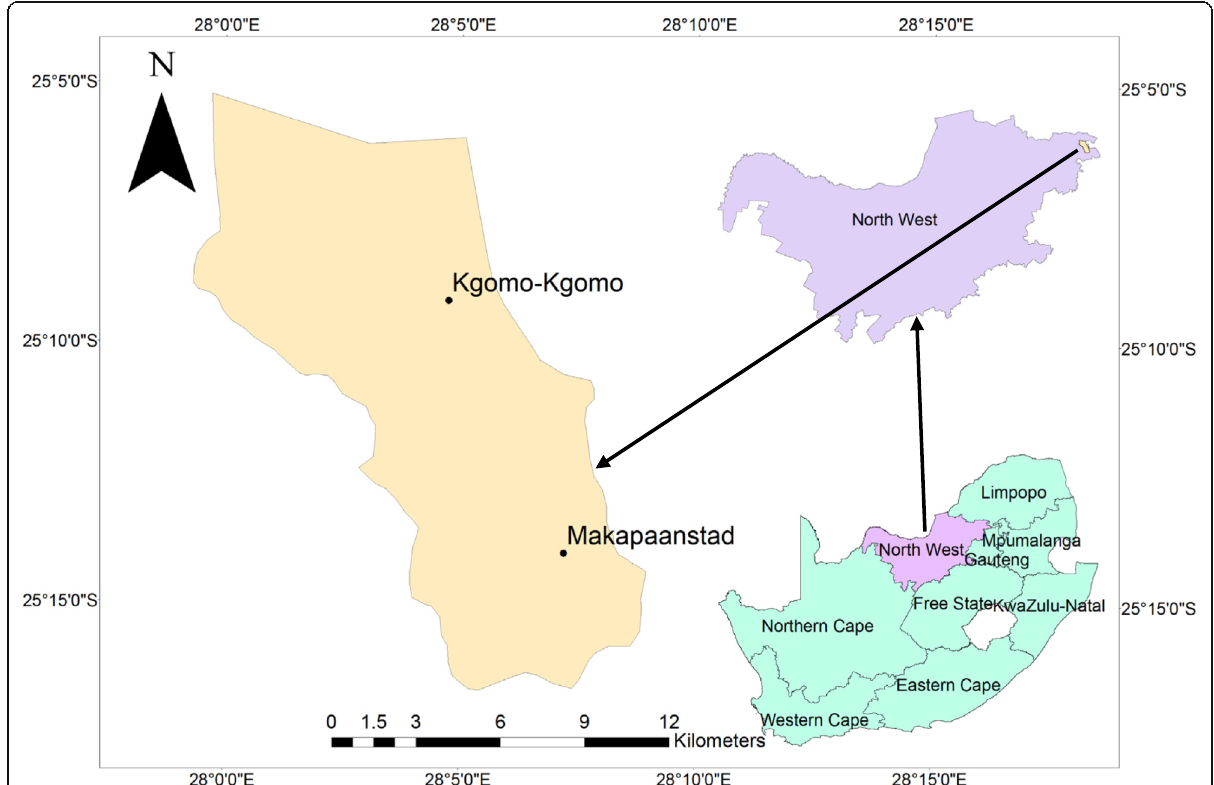
Fig. 1 The map showing the study area of Makapaanstad in North West province of South